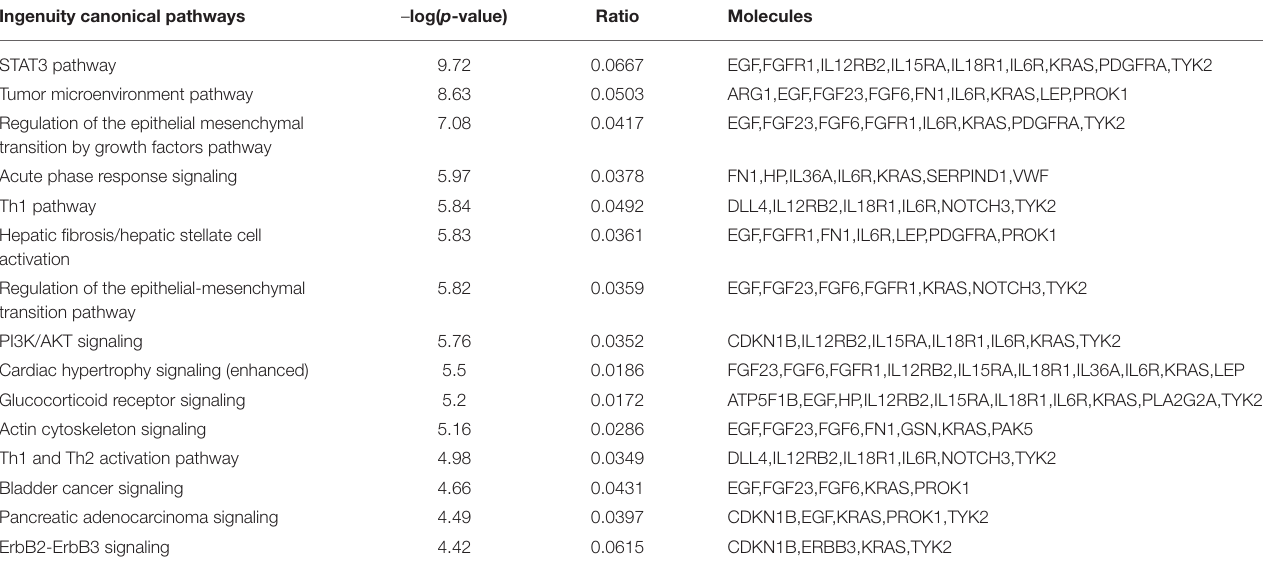
TABLE 3 | Top canonical pathway associated with recovery. Ingenuity canonical pathways – log( p